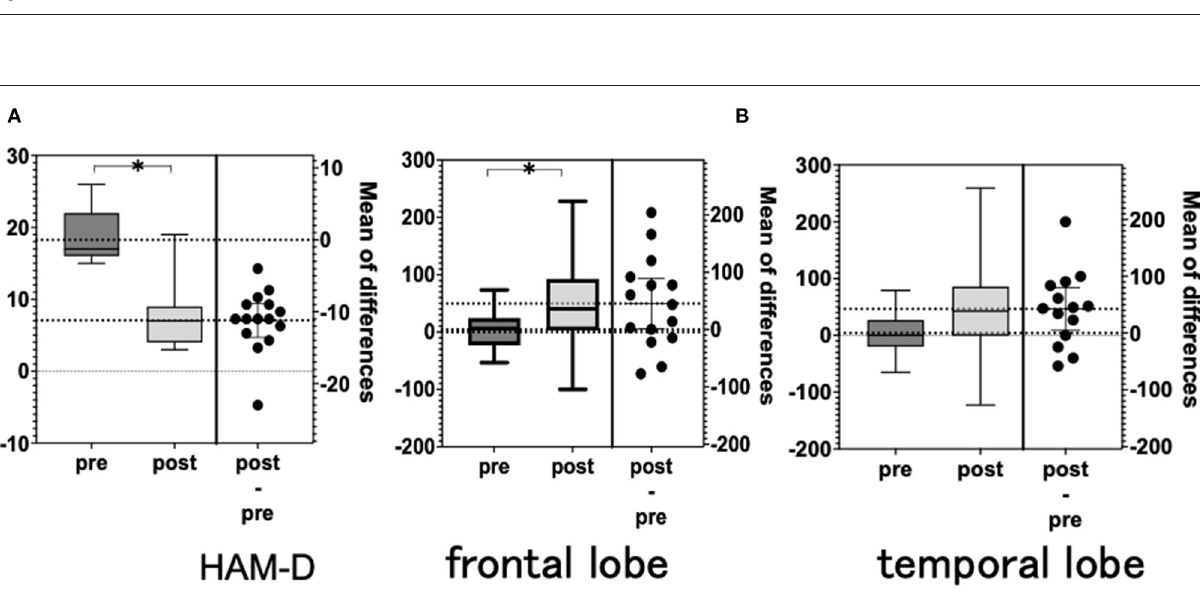
FIGURE 3 | (A) Hamilton Depression Scale (HAM-D). (B) NIRS integral values (average). NIRS, near-infrared spectroscopy. channel 2–14 and channel 1 and 15, respectively ( Figures 2A,B